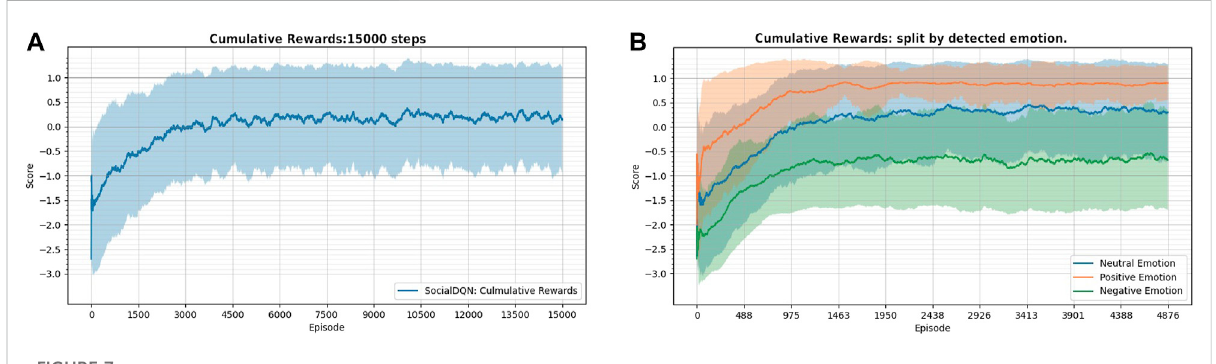
FIGURE 7 (A) themovingaverageshowstherobot ’ scumulativerewardovertheepisodesinblue.Lightbluespacingrepresentsthestandarddeviation. (B) cumulative rewards split by emotion detected by robot at each